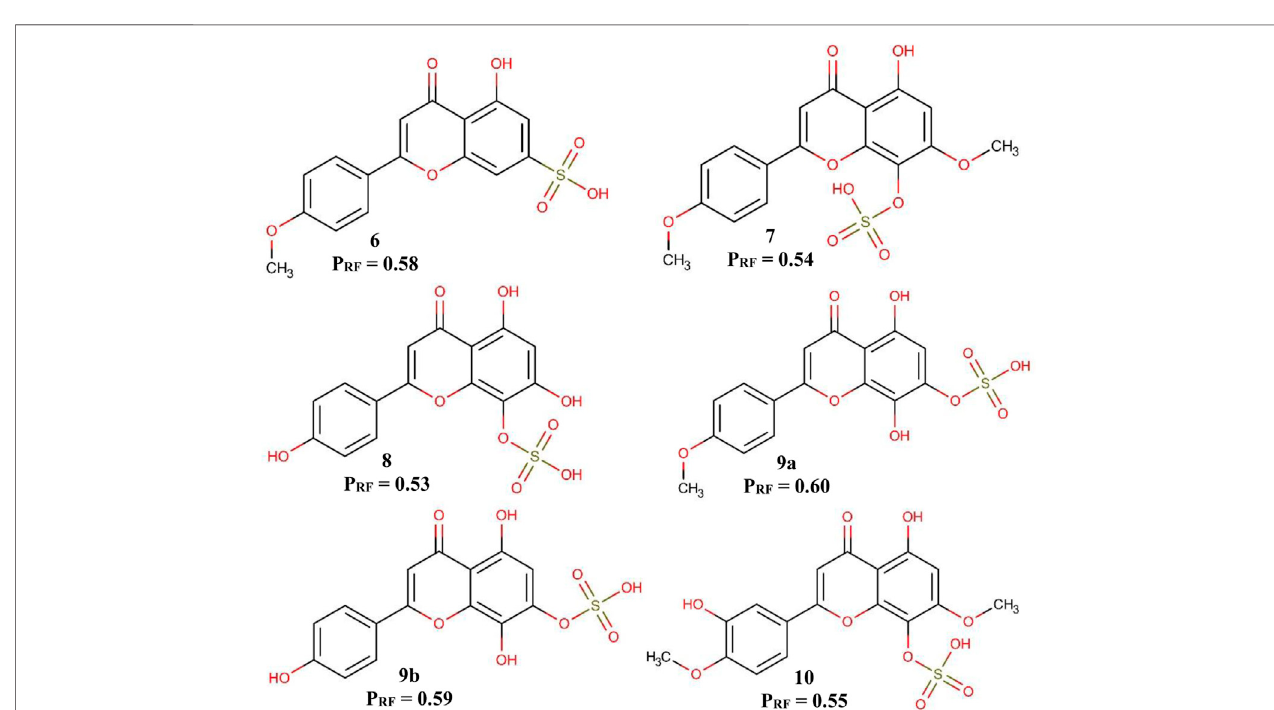
FIGURE 3 | Predicted activity of fl avonoids in the Aedes aegypti model. PRF — Probability of being active in the RF